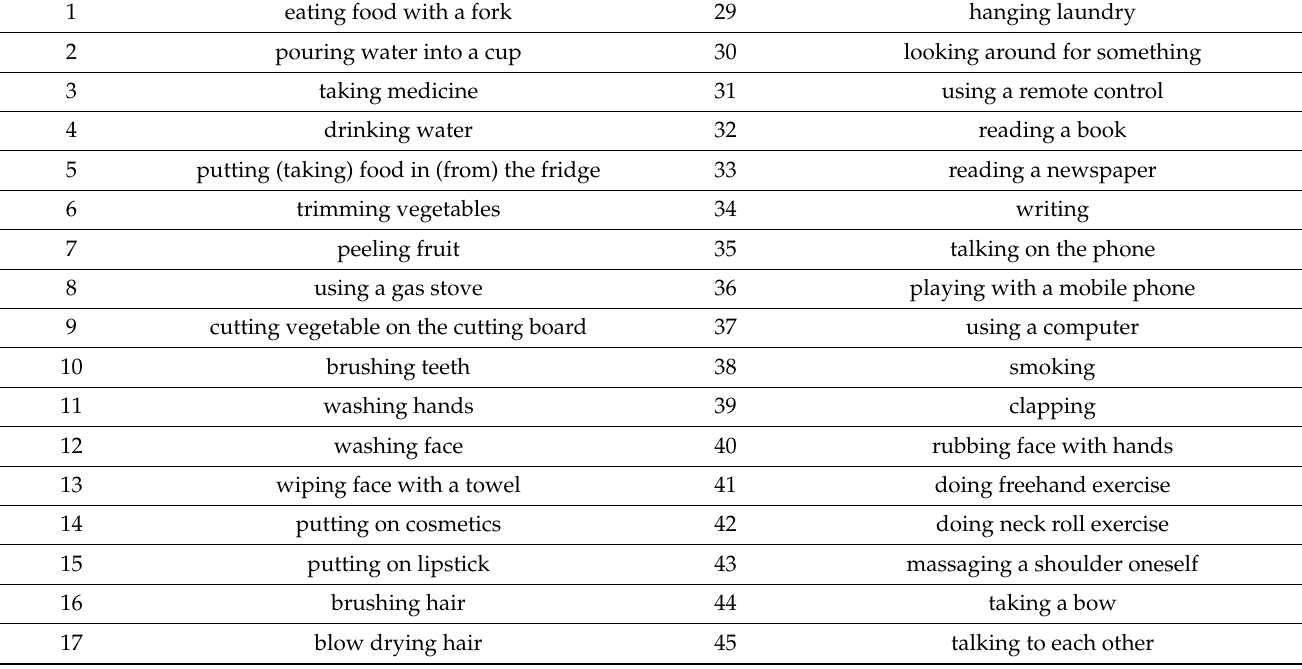
Table 1. Behavior type of Electronics and Telecommunications Research Institute (ETRI)-Activity3D